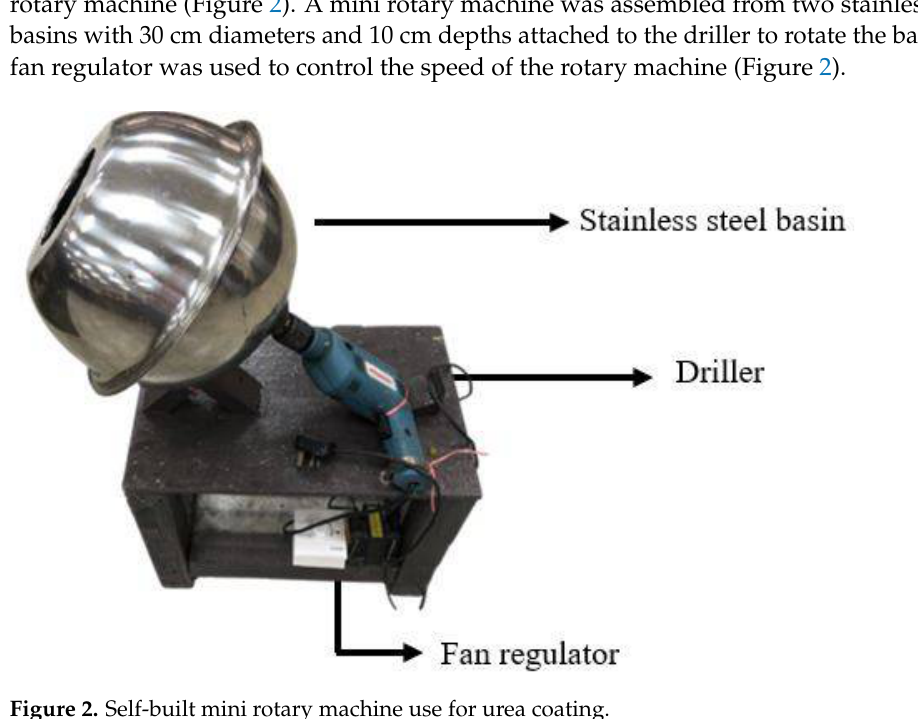
Figure 2. Self-built mini rotary machine use for urea coating.